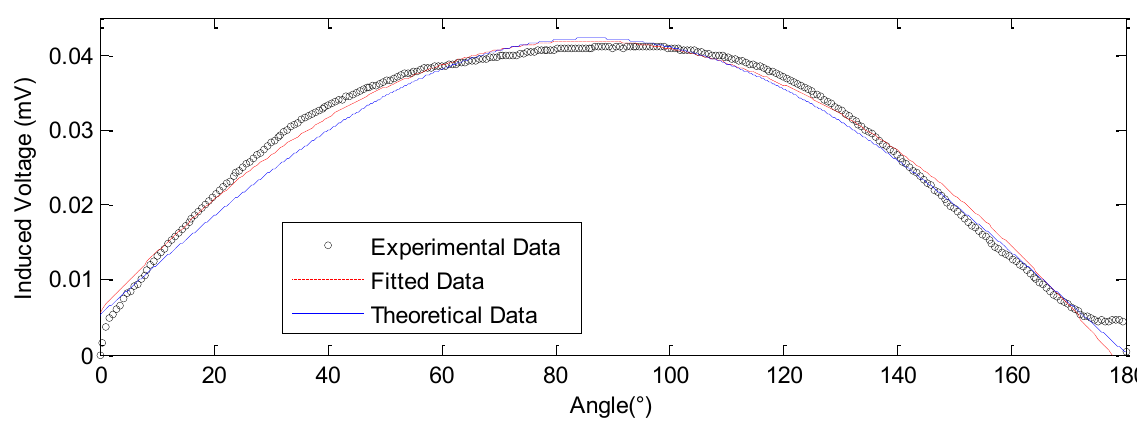
Figure 13. The sensing effect of large angle test.